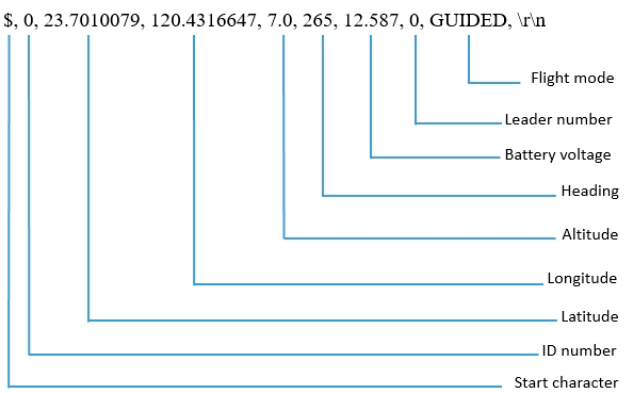
Figure 5. Communication format.